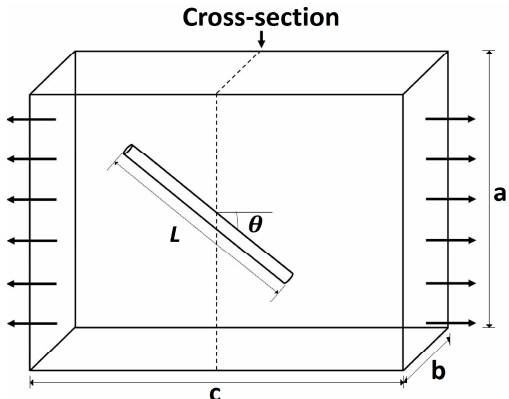
Figure 1. The load carried by a fiber in the loading axis can be calculated through a cross-line perpendicular to the loading direction.